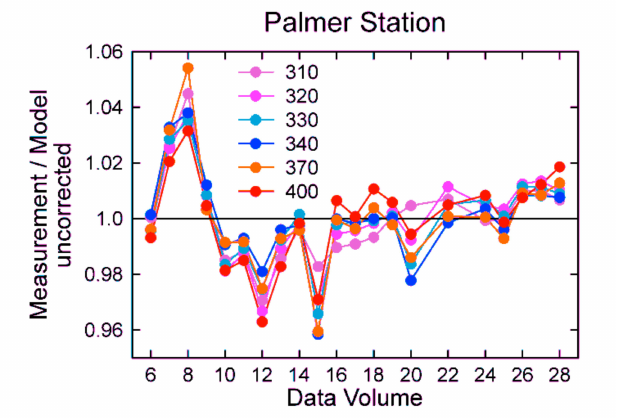
Figure 3. Normalized median ratios of measurement and model at 300, 320, 330, 340, 370, and 400 nm at Palmer Station. Data were calculated from published